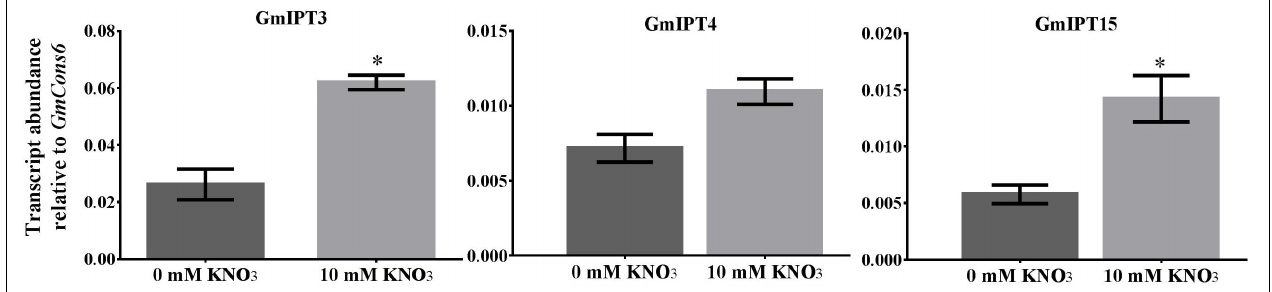
FIGURE 6 | Expression of GmIPT3 , GmIPT4 and GmIPT15 in response to nitrate. Soybean plants were treated with either 0 or 10 mM KNO 3 and roots were harvested from 23-day-old plants. Expression levels are relative to the housekeeping gene GmCons6 . Bars represent mean ± SEM of two biological replicates ( n = 4 plants per replicate). Asterisk shows significant differences in expression (Student’s t -test, ∗ P ≤